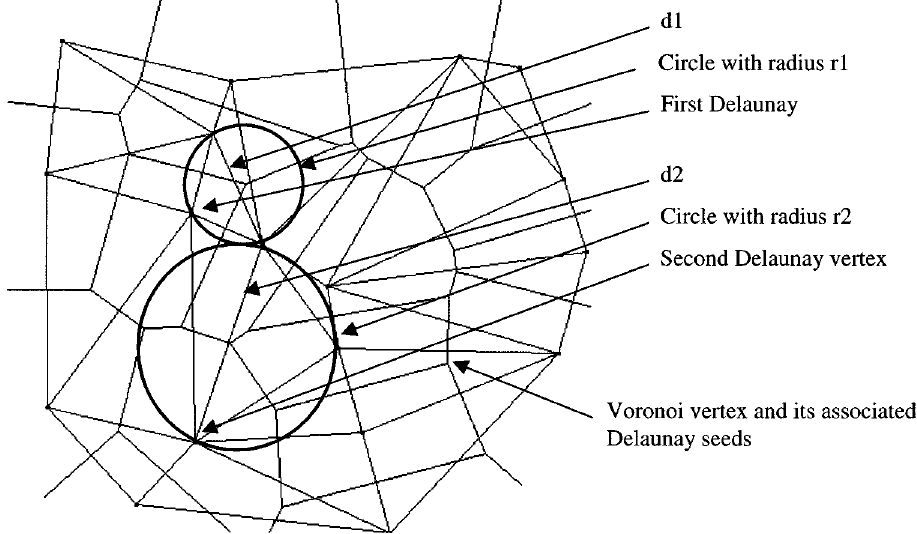
Fig. 2. The Delaunay Triangulation (DT) represents the dual of the VD and is constructed by drawing lines between pointlike seeds in adjacent Voronoi polygons. The completed construction is a triangular network that covers the whole area. A Delaunay network in two dimensions consists of non-overlapping triangles where no pointlike seeds in the network are enclosed by the circumscribing circles of any neighbouring triangle. The VD is shown in blue and the DT in